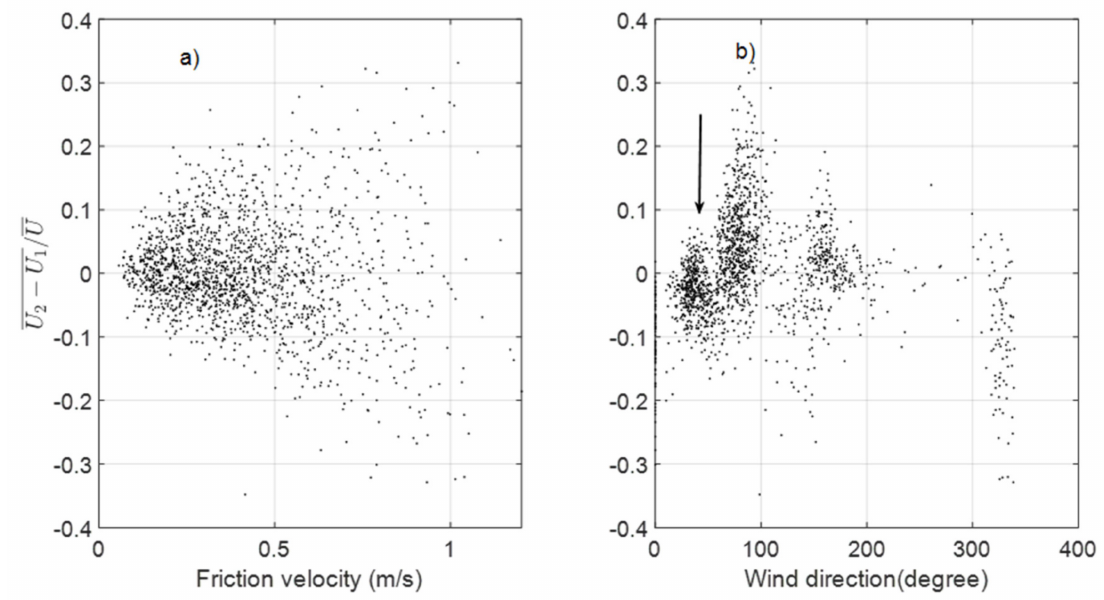
Figure 7. Differences in wind velocity measurements between the two towers normalized by the mean wind velocity versus the friction velocity ( a ) and wind direction ( b ). Arrow indicates the unobstructed